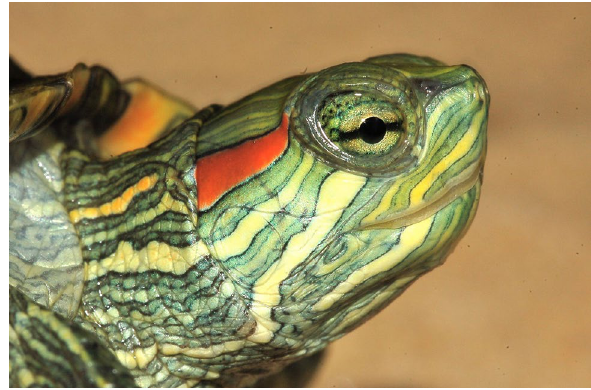
Fig. 1 A red-eared slider turtle ( Trachemys scripta elegans